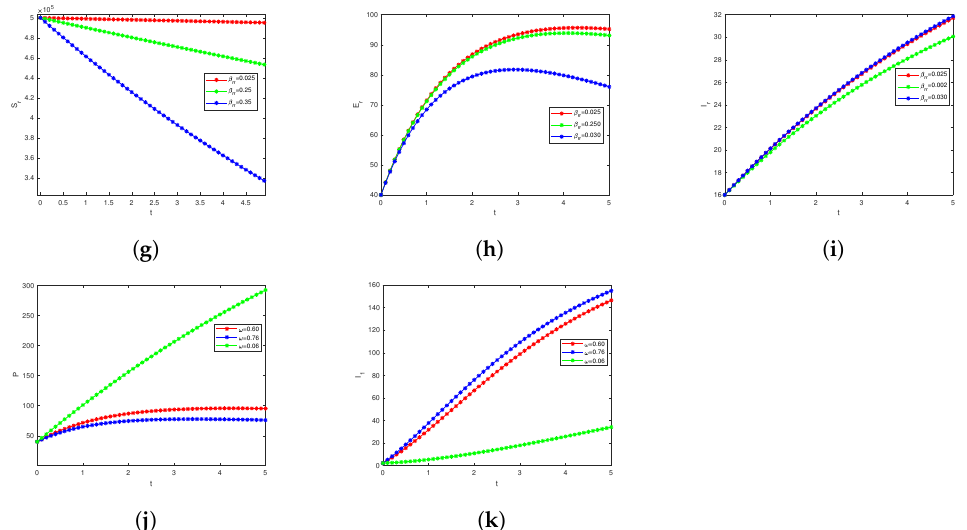
Figure 4. Patterns of the model’s compartments based on varying some crucial parameters to show the overall transmission behaviour of mpoxv.